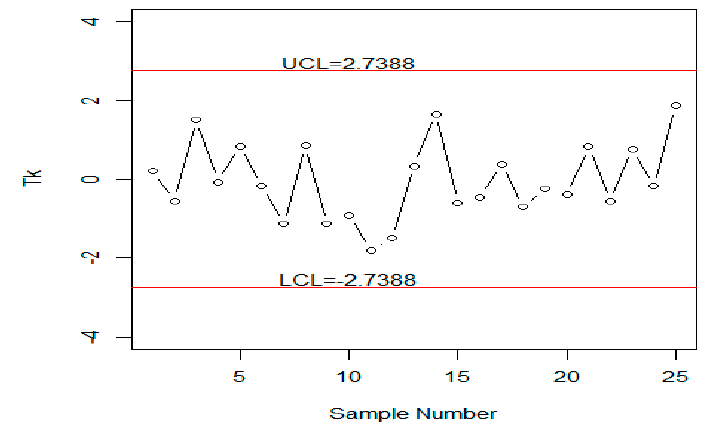
Figure 6. The existing chart proposed by Reference [7] for real data.